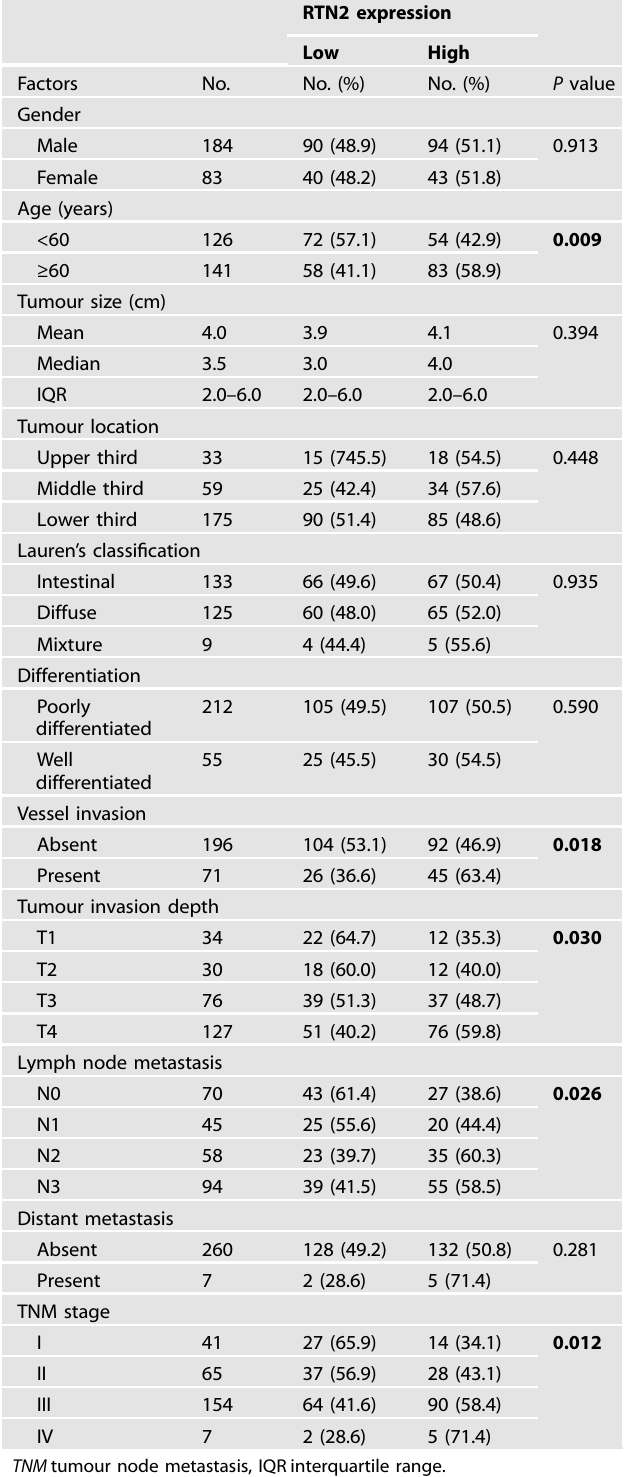
Table 1. Relationship between RTN2 expression and clinicopathological characteristics in patients with gastric